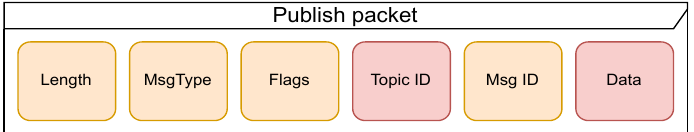
Figure 4. Publish packet format.